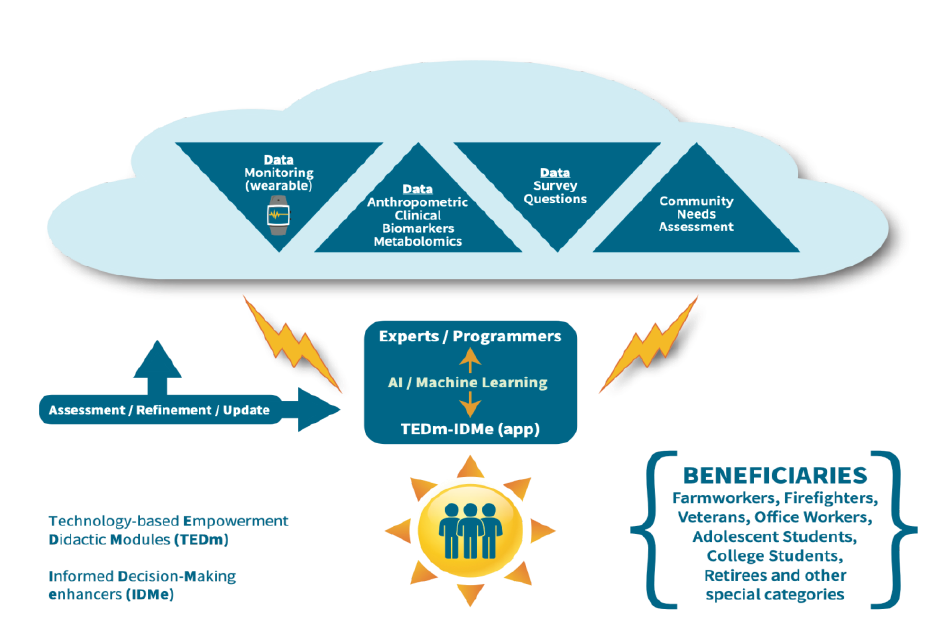
Figure 1. Conceptual graphical schematic of the TEDm-IDMe app approach.